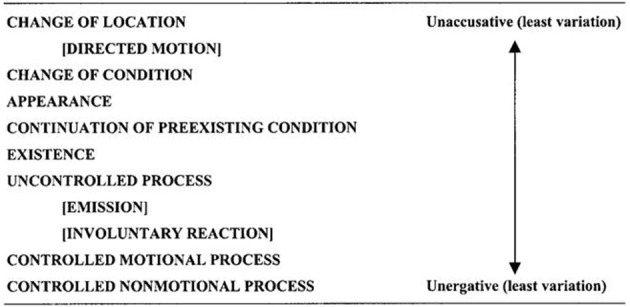
Sorace's unaccusativity hierarchy (Sorace and Shomura, 2001).